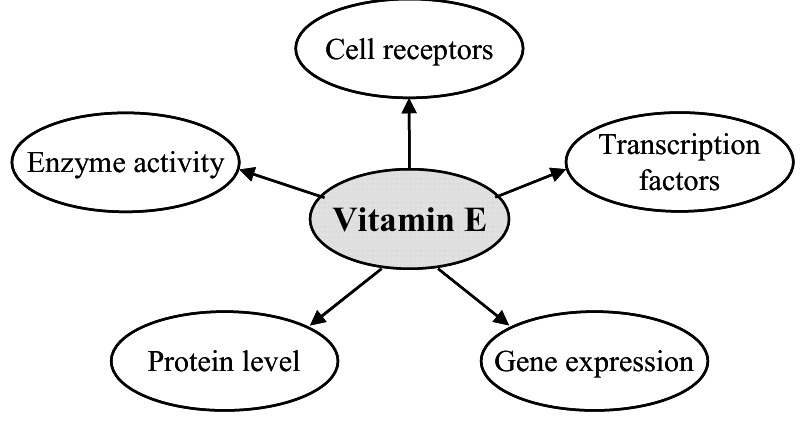
Figure 4. Vitamin E is a cell signalling molecule and affects cell receptors, transcription factors, gene expression, protein levels and enzyme activities of vitamin E specific molecular